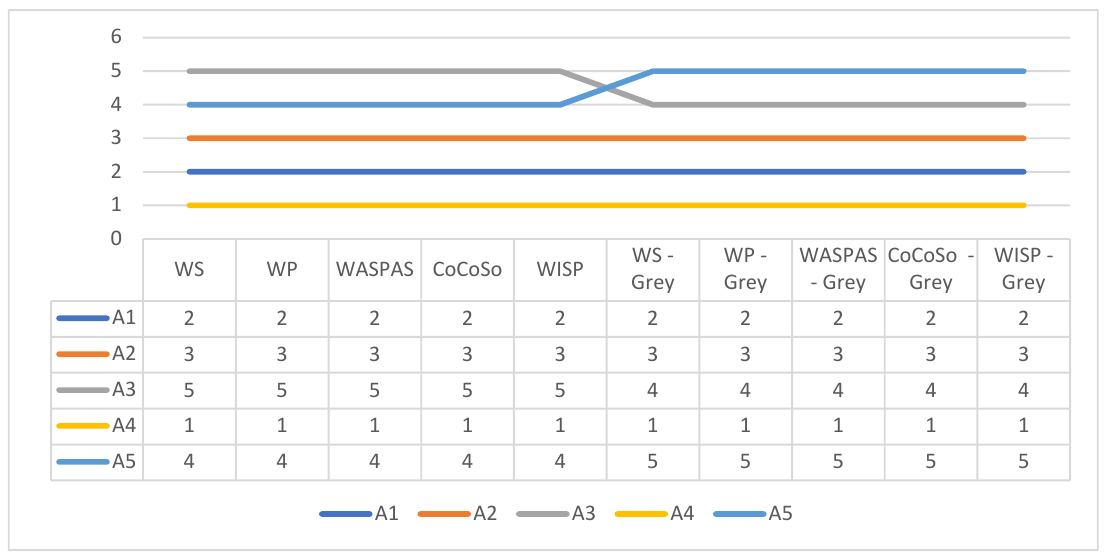
Figure 3. Ranking orders of alternatives obtained on the basis of 150 virtual respondents.